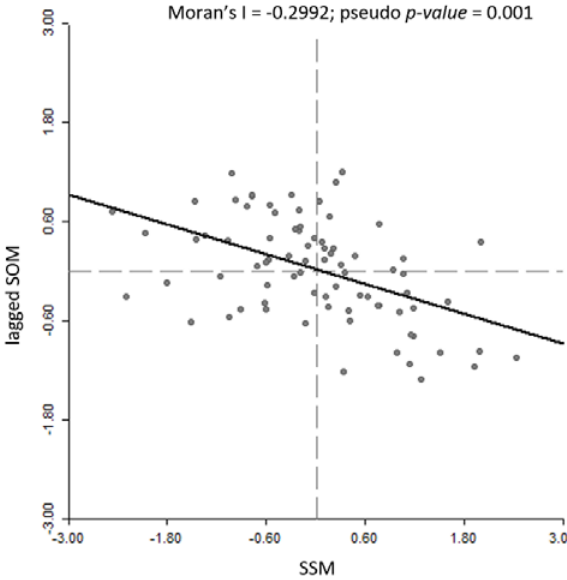
Figure 5. Bivariate Moran’s I showing the spatial relationship between observed soil surface microtopography (micro-elevation) and observed soil organic matter content